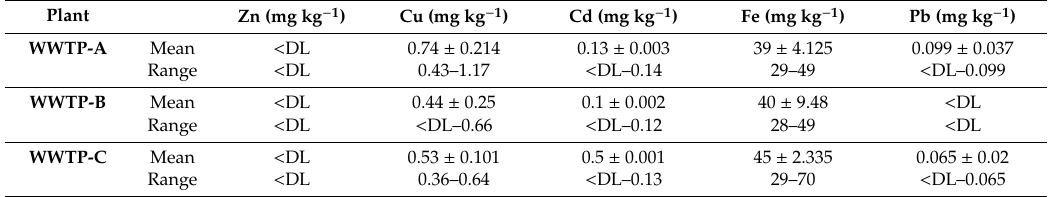
Table 3. Levels of heavy metals in sludge samples from WWTP-A, B and C (mg kg − 1